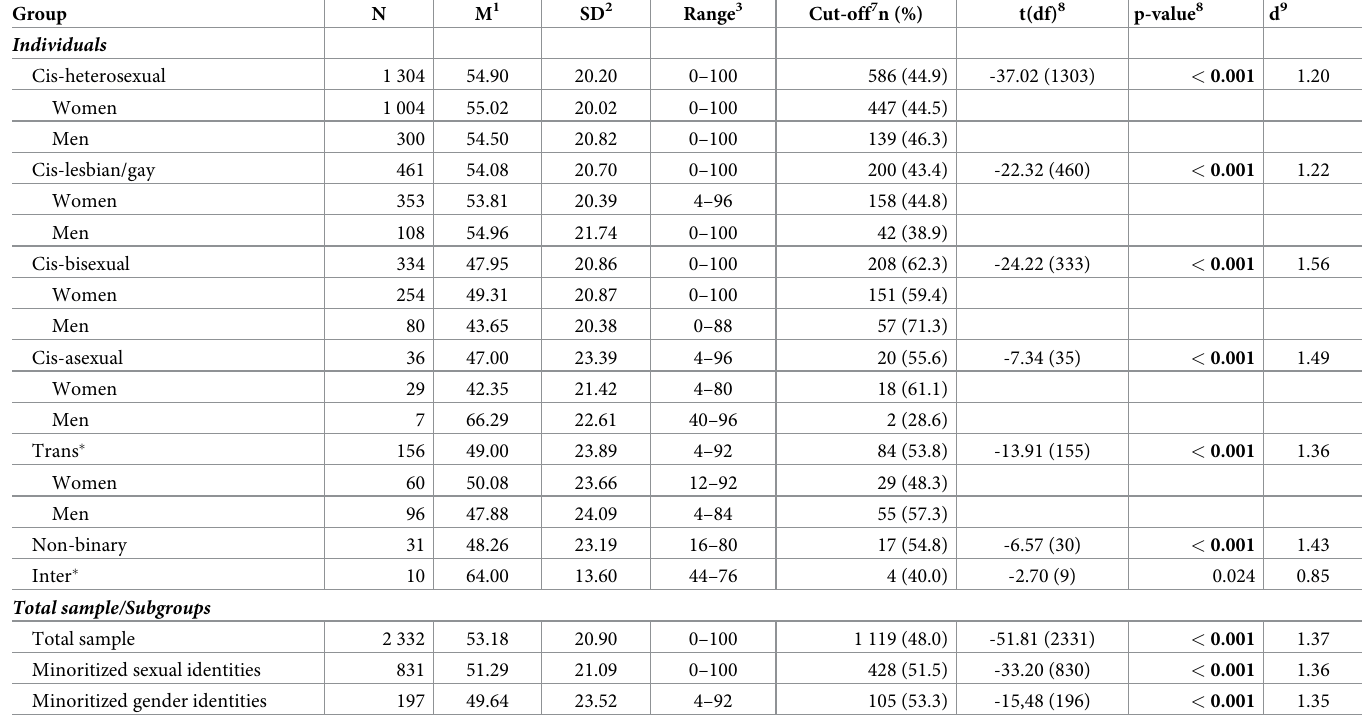
Table 2. Means, standard deviations and ranges for the WHO-5 across individuals and subgroups.